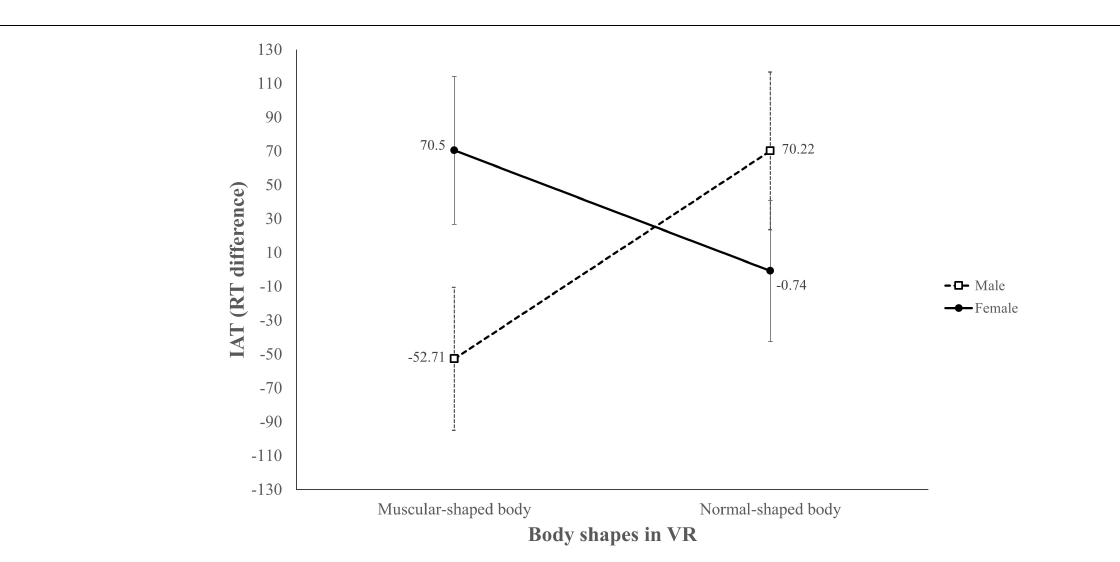
FIGURE 7 | Interaction between avatar body shape and sex of participants in predicting participants’ self-concept after the VR